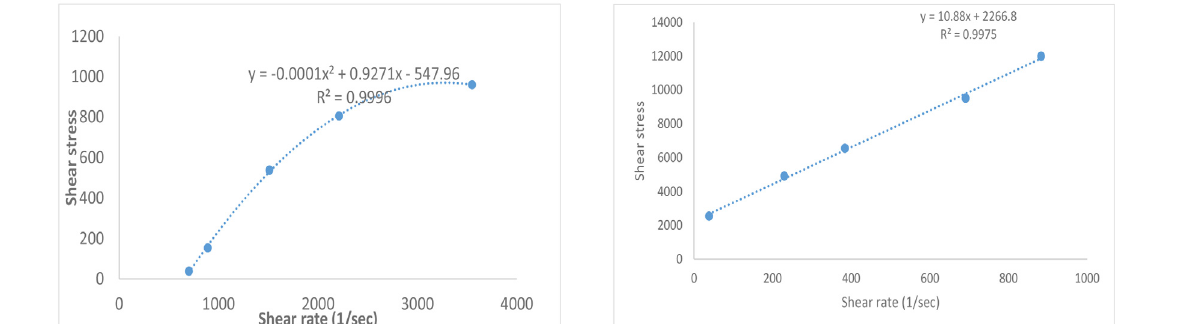
Fig. 6. Profile viscosity of sample F2: Containing organo-di- methicone and eucerin.